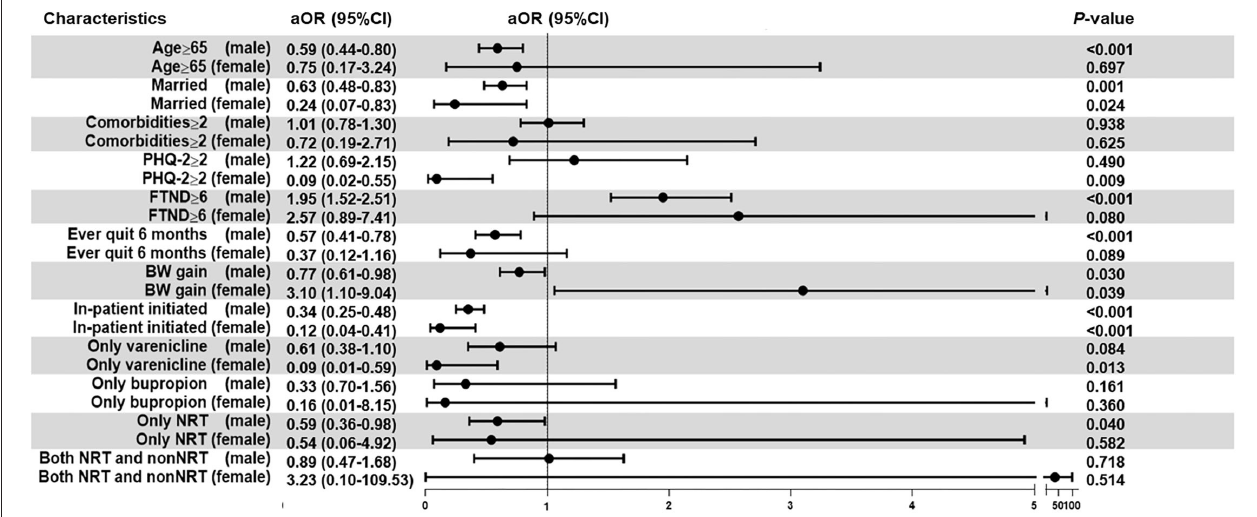
9.04) and negatively associated in the men (adjusted OR: